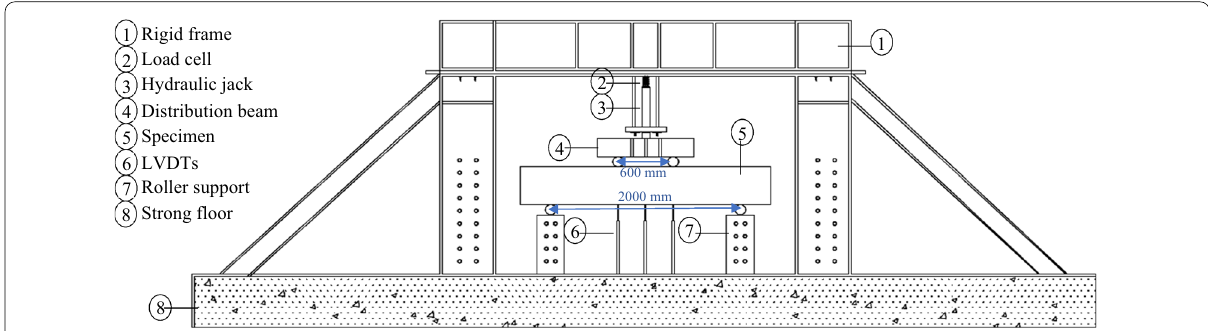
Fig. 6 Schematic diagram of test setup and instrumentation.